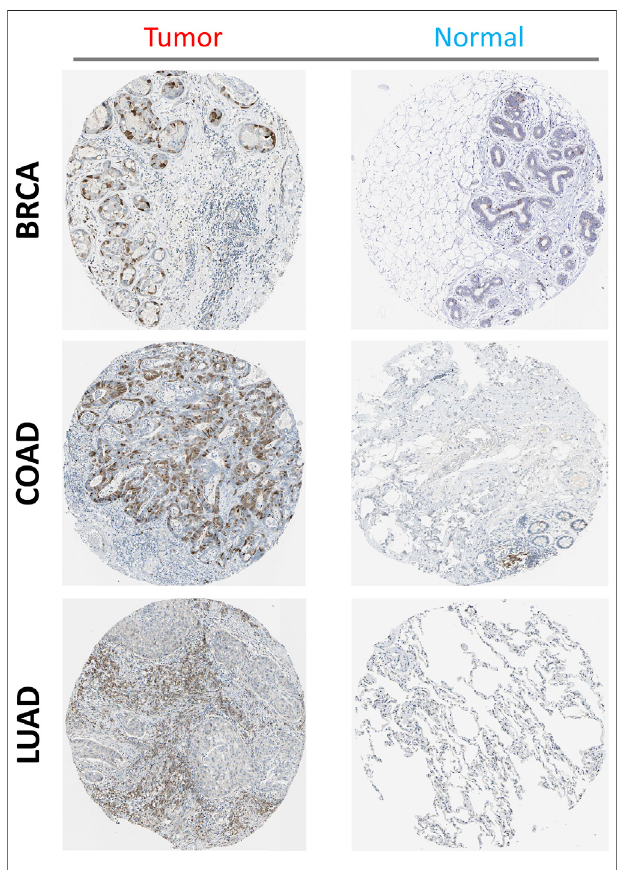
FIGURE 4 | The expression of PTTG1 in different tumors at translation level: three types of tumors were shown (BRCA, COAD and LUAD) compared to the corelating normal tissue (Breast, Colon and